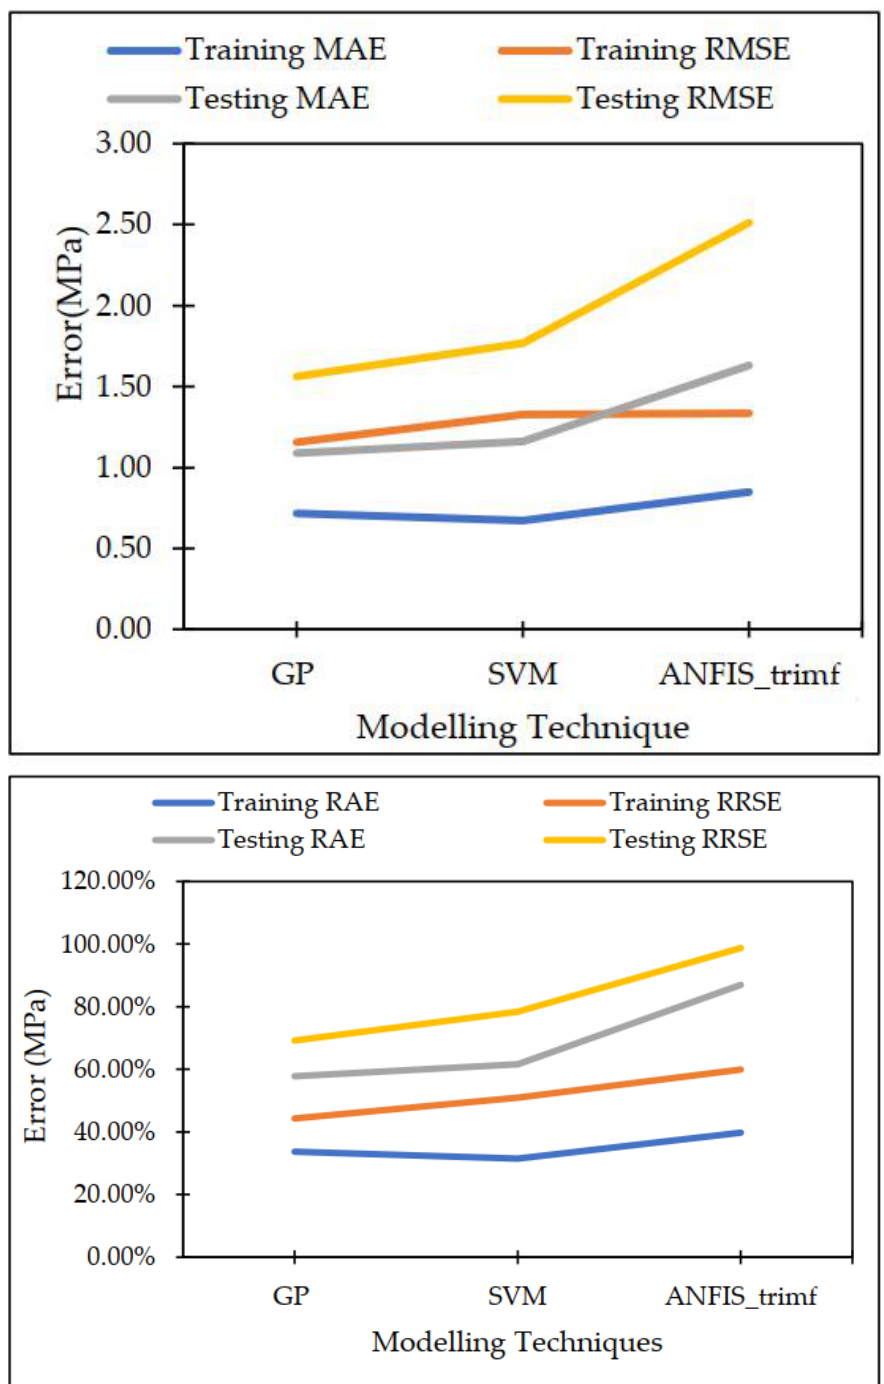
Figure 10. Performance Evaluation by Statistical Parameters.